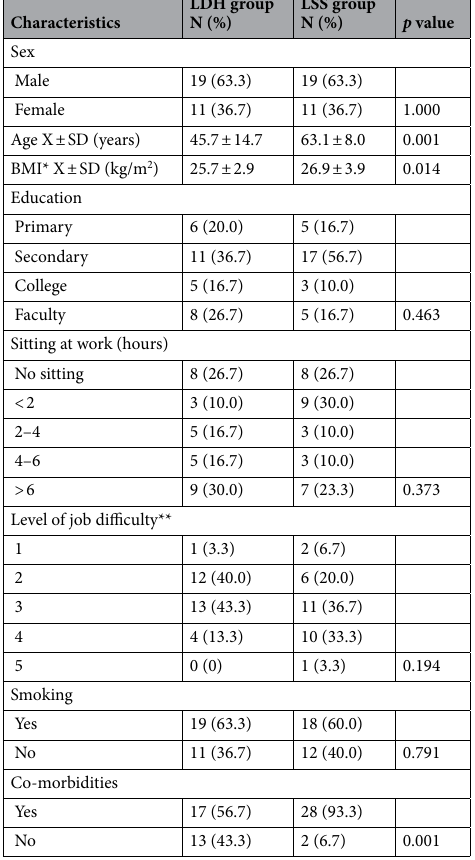
Table 1. Demographic and social characteristics of patients included in the study. *Body mass index (BMI) is defined as the body mass divided by the square of the body height, and is expressed in units of kg/m 2 . **Patients independently graded the difficulty of their work from 0 to 5 according to physical